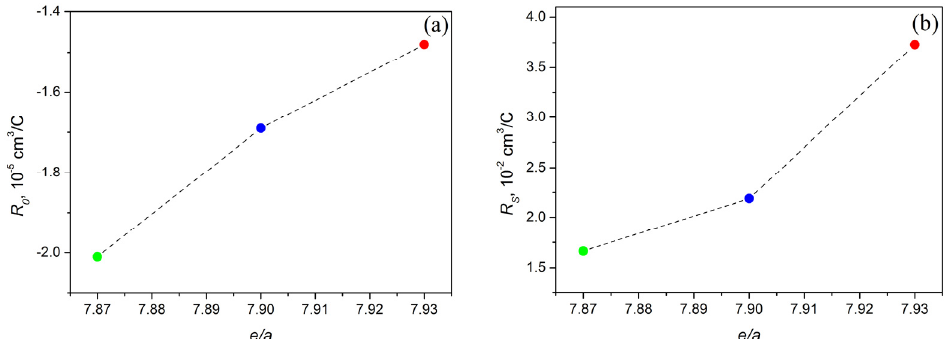
Figure 8. Dependences of the normal R 0 ( a ) and anomalous R S ( b ) Hall coefficients on the e / a ratio: green circle—Ni 45 Mn 43 In 12 , blue circle—Ni 46 Mn 42 In 12 , red circle—Ni 47 Mn 41 In 12 .